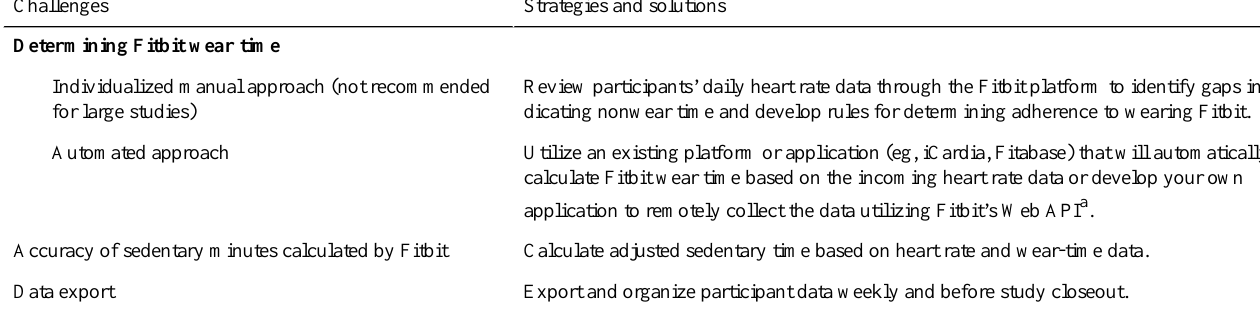
Table 4. Challenges and solutions or strategies for utilizing the Fitbit physical activity (PA) tracker in health interventions at the data management stage.